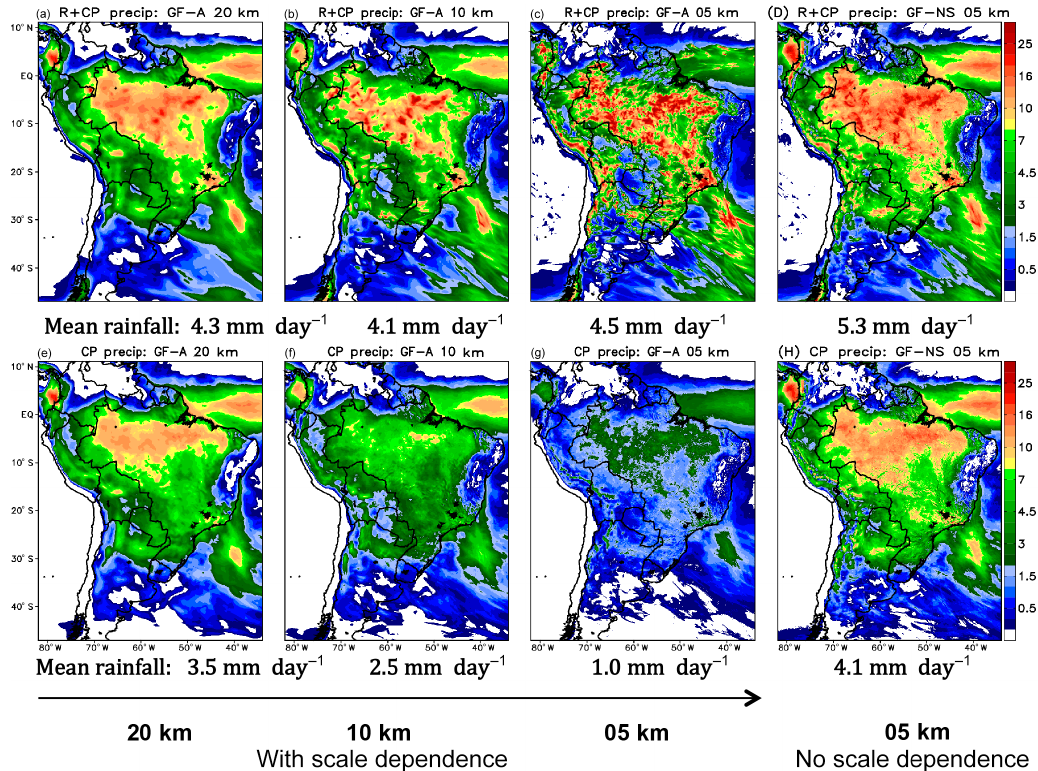
Figure 6. Averaged precipitation rates over 15 runs for total precipitation (a, b, c) and convective (non-resolved) precipitation (e, f, g) , using the scale-dependence formulation (GF-A) and horizontal resolutions of 20km (a, e) , 10km (b, f) , and 5km (c, g) . The column on the right (d, h) depicts results on 5km without the scale-dependence formulation (GF-NS). Units are mmday − 2 .